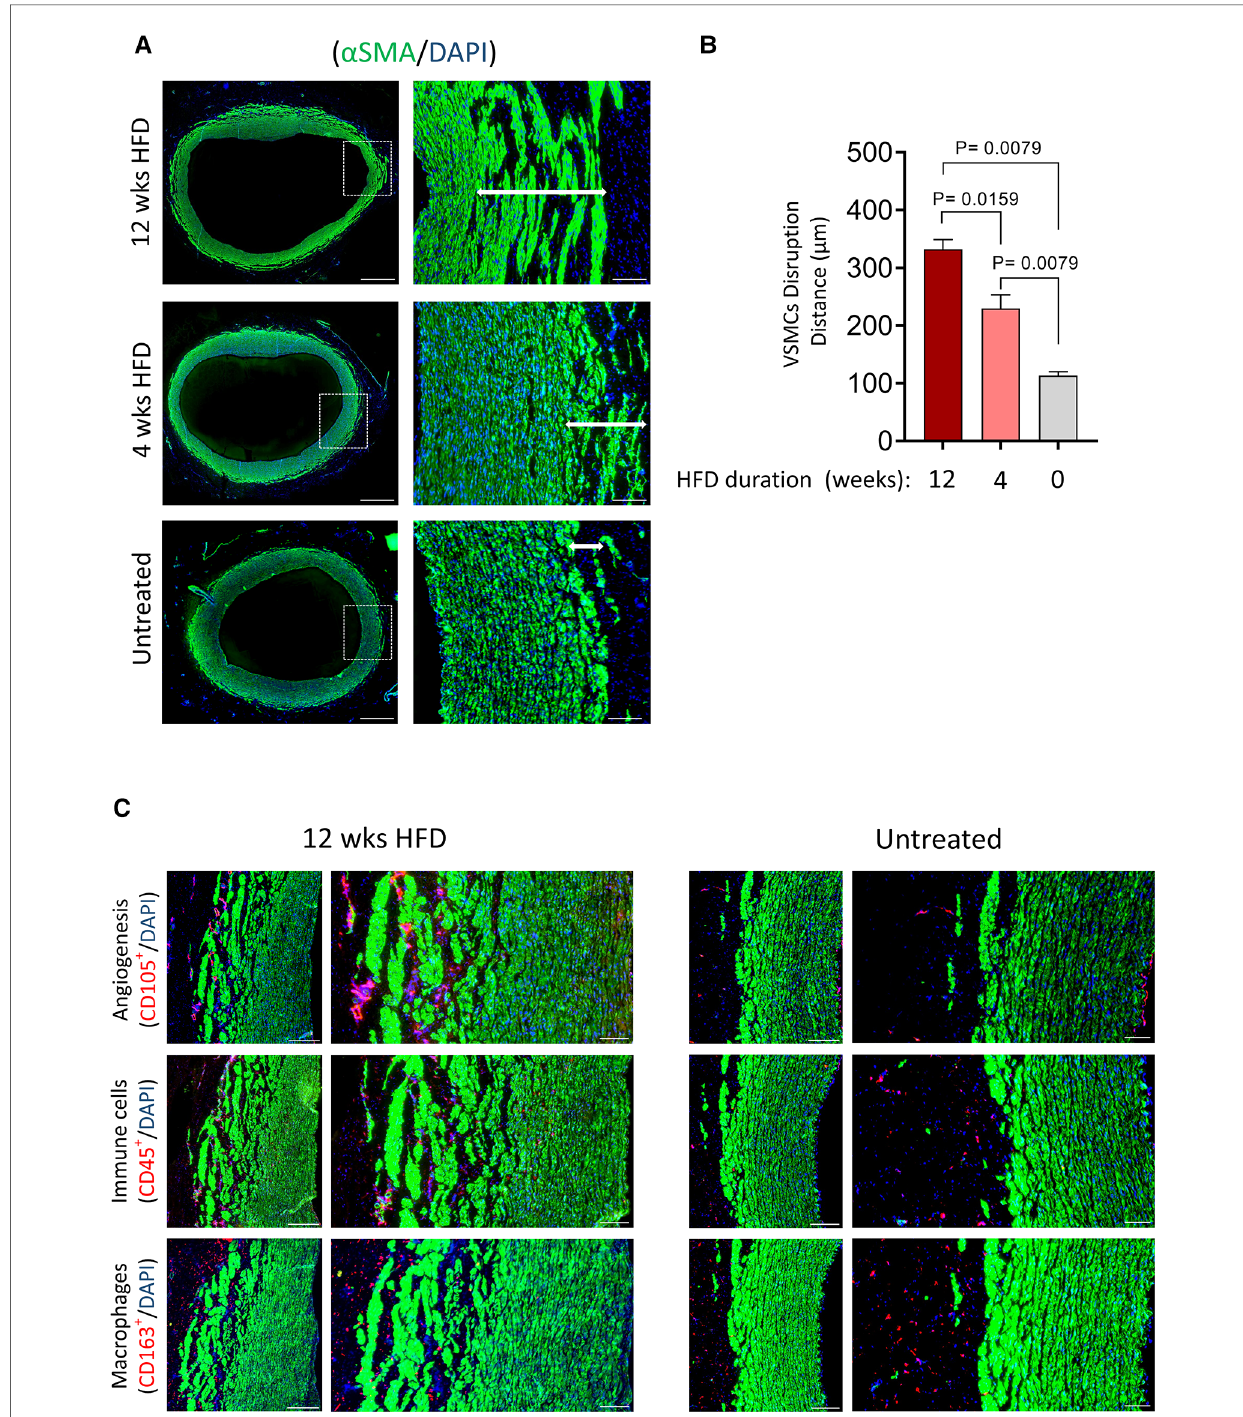
FIGURE 7 Disruption of VSMCs in response to hyperlipidemia correlates with high in fi ltration of VV and immune cells. ( A ) Tissue cross-sections of the aorta from HFD groups and normal chow diet (obtained from identical sections of the abdominal aorta) were stained for vSMCs ( α SMA, green). The magni fi ed fi eld of view shows disruption of vSMCs from the media towards the adventitia (arrow). Scale bar: 100 µm. ( B ) Bar graphs show the distance of vSMC disruption in µm for each group (mean±SEM, n =5, ** p =0.0159 and p =0.0079 by Mann – Whitney test). ( C ) Tissues, as shown in ( A ), were stained for vSMCs ( α SMA, green) and VV (CD105, red) or in fl ammatory cells (CD45, CD168, red). Nuclei DAPI (blue). Scale bars: 100